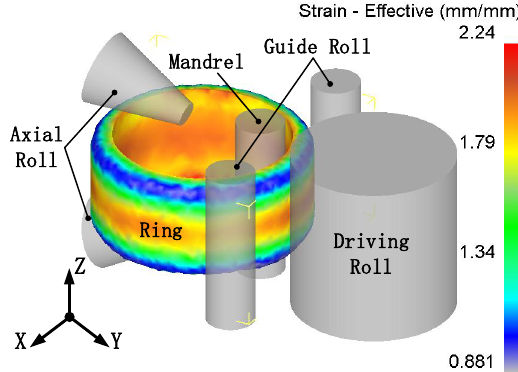
Figure 4. Rolling finite element model.